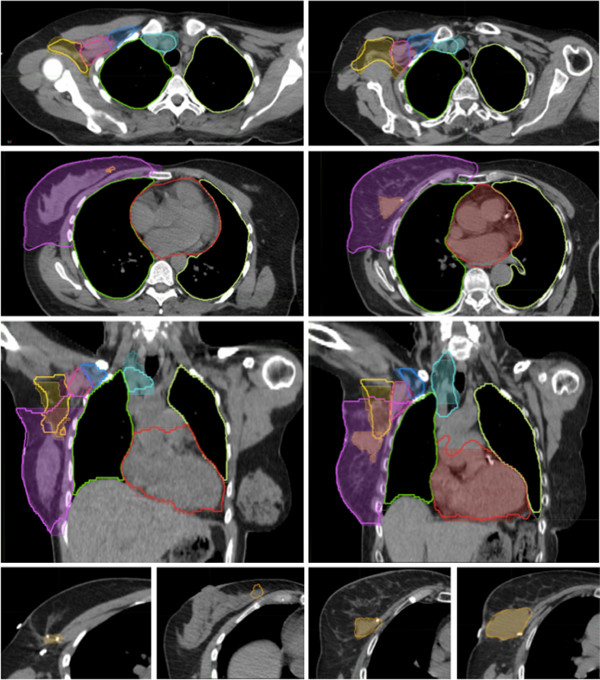
Atlas-predicted contouring for high risk breast cancer post lumpectomy. Representative slices of two contoured right breast-post lumpectomy cases comparing atlas predicted auto contours (bold outline) to manual contoured standard (thin outline with colourwash). Atlas subjects #5 (left images) and #14 (right images). ROIs demonstrated are CTVBRCWL (purple), CTVAX1 (yellow), CTVAX2 (pink), CTVAX3 (dark blue), CTVSCV (teal), LUMP (orange), H (red), LL(light yellow), RL(green). Bottom panels demonstrate the high degree of variability in seroma (LUMP) prediction with the atlas being unable to predict the subtle seroma (left images, DSC = 0) while contouring a more readily identifiable seroma with reasonable accuracy (right images, DSC = 0.89).